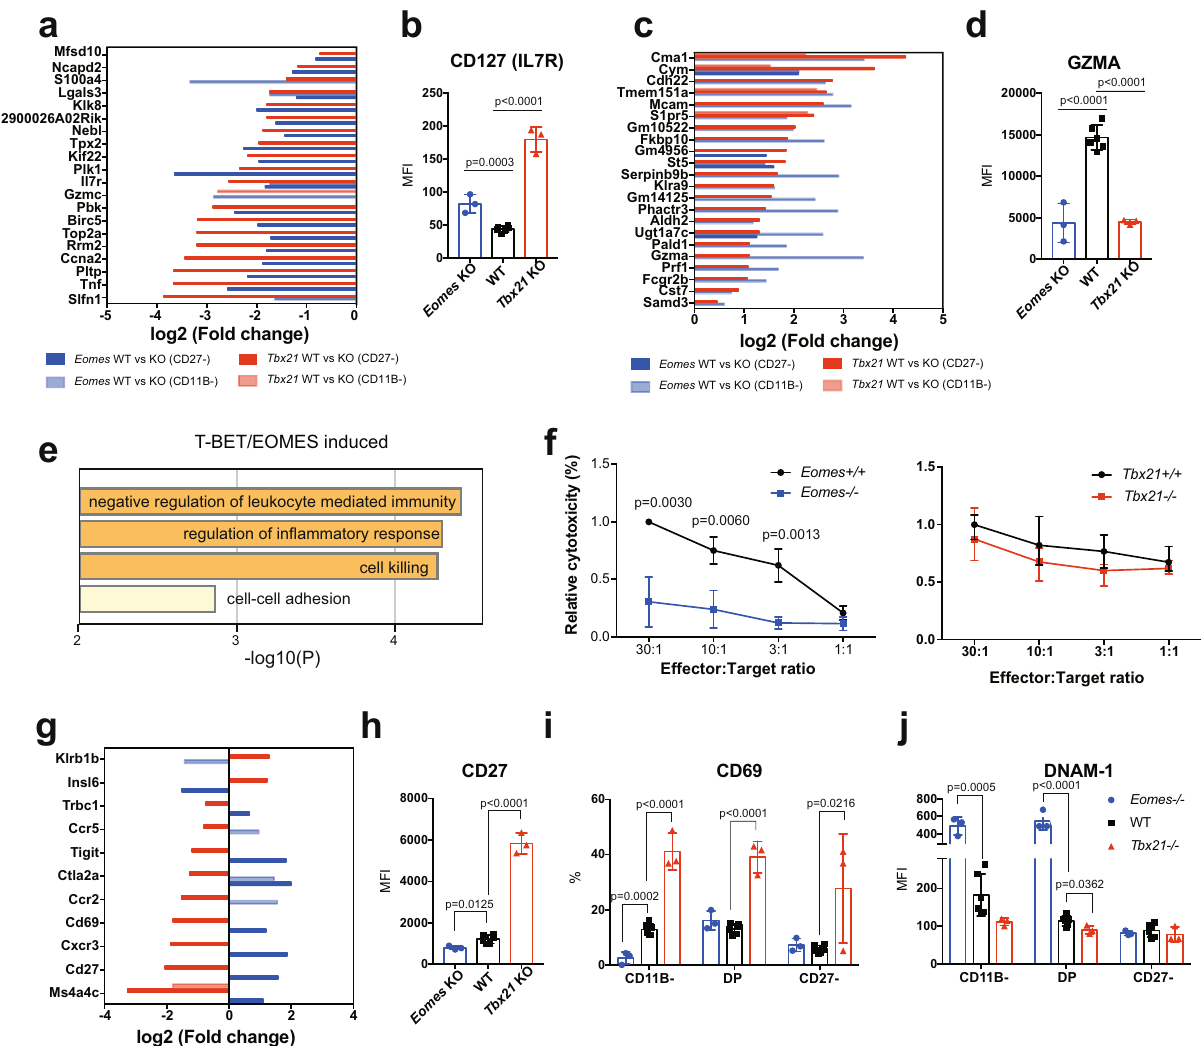
Fig. 5 Shared transcriptional activities of T-BET and EOMES in NK cells. RNA-seq analysis of sorted Tbx21 − / − , Eomes − / − and appropriate control CD11B- and CD27 − NK cells ( n = 3 per group with three sorts in total). DEGs were selected based on adjusted p < 0.05. a T-BET/EOMES co-repressed genes in immature or mature NK cells. Bar graphs show the log2 transformed fold change of genes between controls and T-BET or EOMES de fi cient mice, as indicated. b Bar graph showing the mean ± SD of IL7R expression in NK cells of the indicated genotype as measured by fl ow cytometry. The different controls for each genotype are pooled and annotated as “ WT ” in the graph which is same for the following graphs in ( d , h – j ). N = 3. c T-BET/EOMES co- induced genes in immature or mature NK cells, Bar graphs show the log2 transformed fold change of genes between controls and T-BET or EOMES de fi cient mice, as indicated. d Bar graph showing the mean ± SD of GZMA expression in NK cells of the indicated genotype as measured by fl ow cytometry. N = 3. e Functional annotation of the T-BET/EOMES induced gene set using Metascape. Bar graphs show selected terms among the most signi fi cant ones. f Cytotoxicity assay using sorted Tbx21 − / − , Eomes − / − and appropriate control CD27 − NK cells as effectors and RMA-KR-Nano-luc cells as targets. Graphs show the mean cytotoxicity± SD. Data are from 3 mice in each group, pooled from two independent experiments. g Bar graph showing the log2 transformed fold change of genes regulated in opposite ways by T-BET and EOMES, between controls and T-BET or EOMES de fi cient mice, as indicated. N = 3 – 6. h – j Bar graphs showing the mean ± SD of CD27 ( h ), CD69 ( i ) and DNAM-1 ( j ) expression in NK cells of the indicated genotype as measured by fl ow cytometry. N = 3. Unpaired t tests (two-tailed) were used for statistical analysis of data presented in this fi